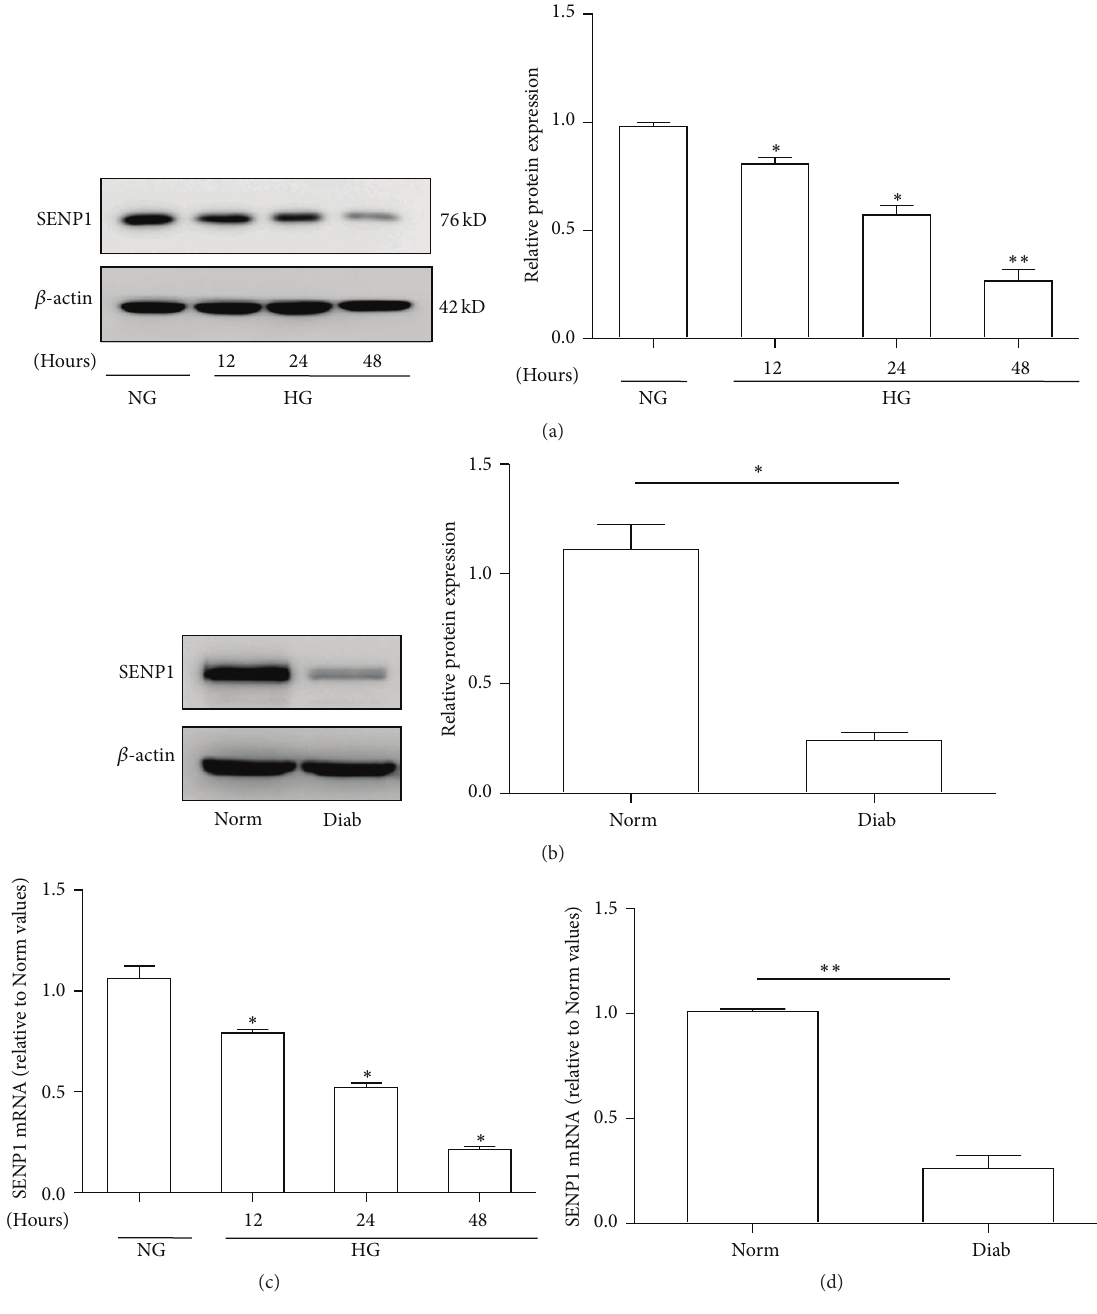
Figure 2: High glucose inhibited SENP1 expression in BRPCs and retinas. (a) Western blot analyses of SENP1 protein expression in BRPCs cultured in normal glucose (NG) and high glucose (HG) (12h, 24h, and 48 h). (b) Western blot analyses of SENP1 protein expression in the retinas of normal (Norm) and diabetic (Diab) rats. (c) Analyses of SENP1 mRNA in BRPCs cultured in normal glucose (NG) and high glucose (HG) (12h, 24 h, and 48 h). (d) Analyses of SENP1 mRNA in the retinas of normal (Norm) and diabetic (Diab) rats. Data are presented as their means ± SEM. Bars indicate SDs. ∗ 𝑃 < 0.05 versus NG or Norm; ∗∗ 𝑃 < 0.01 versus NG or Norm.